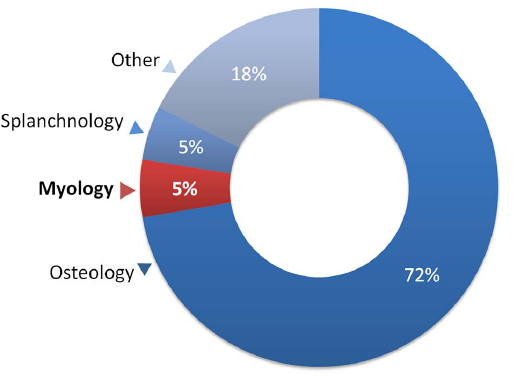
Figure 2. Categories of morphological synapomorphies delim- iting the 50 major monophyletic groups of Percomorphacea. Synapomorphies and classification based on Wiley and Johnson